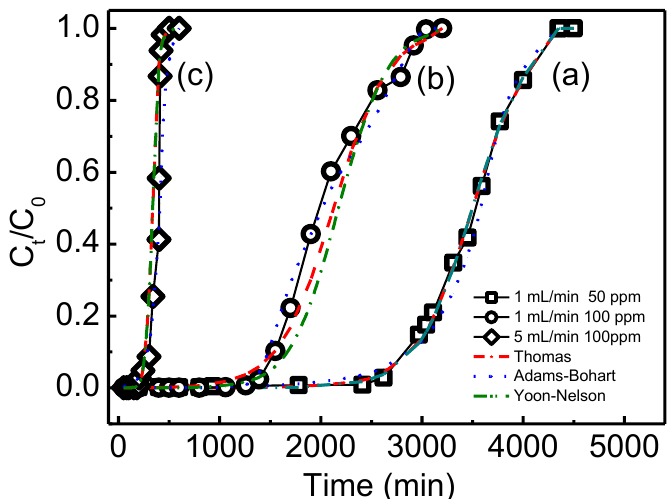
Figure 10. Breakthrough curves with concentration 50 mg / L at flow rate 1 mL / min (a), with concentration 100 mg / L at flow rate 1 mL / min (b), and with concentration 100 mg / L at flow rate 5 mL / min (c).